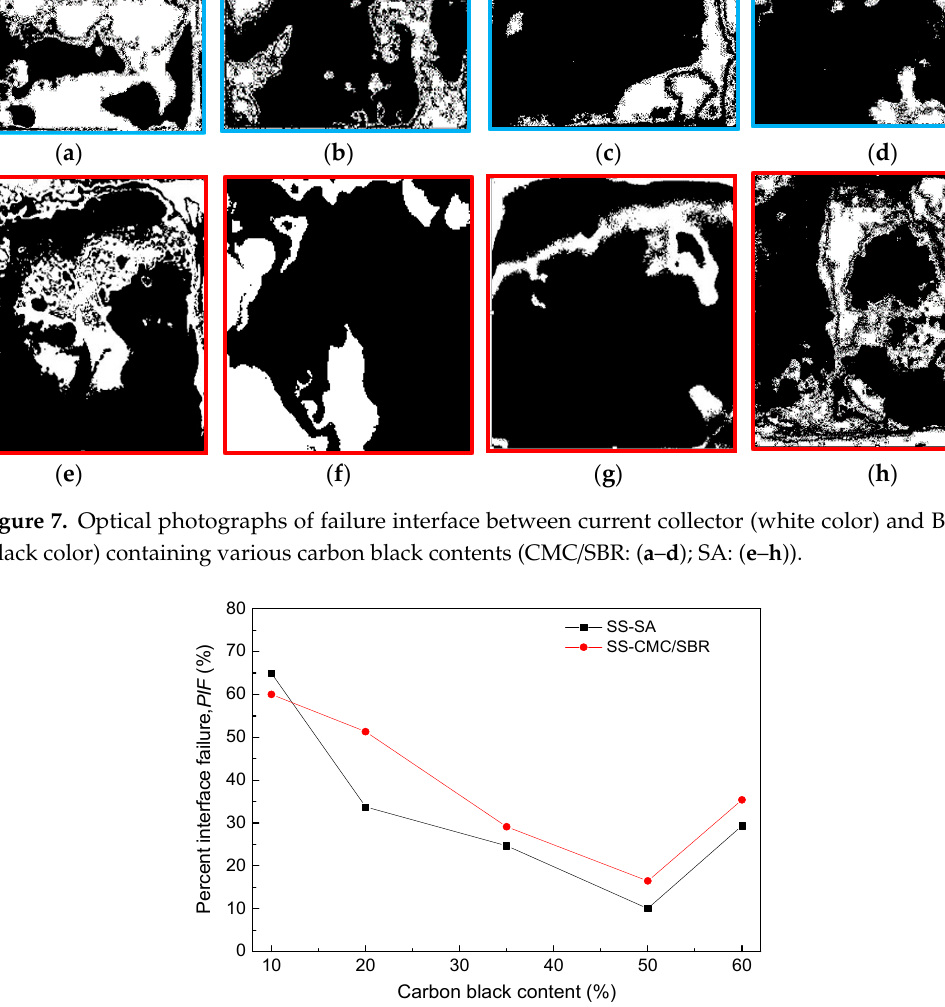
Figure 8. E ff ect of SS content on percent interface failure (PIF) of BCC with various aqueous polymers.